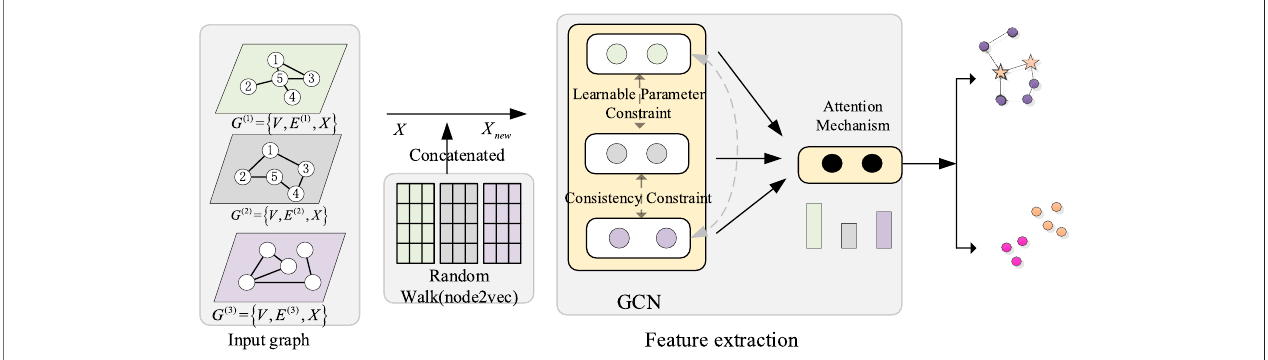
FIGURE 2 | The framework for our proposed method of attributed multiplex network